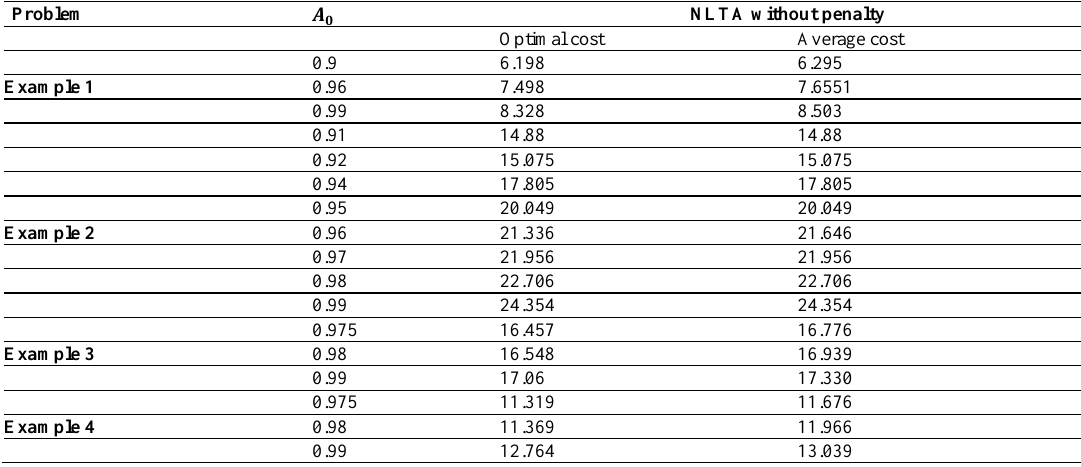
Table 6. Results of the NLTA without penalty: case of multi-state